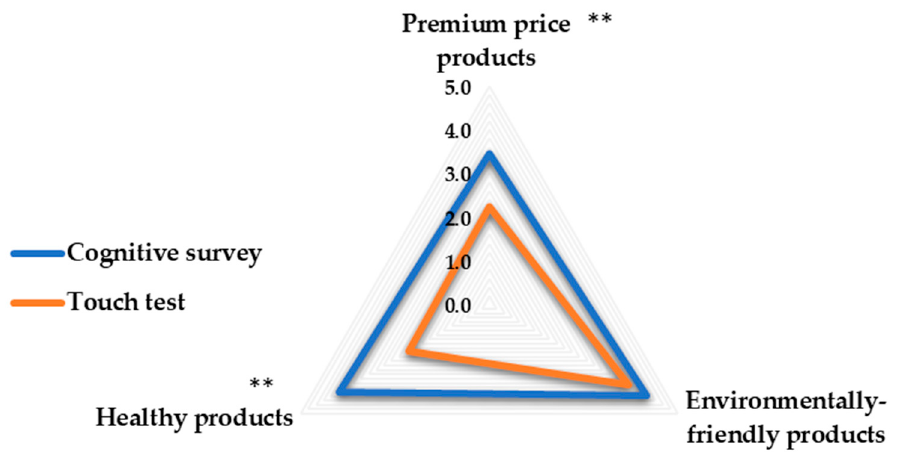
Figure 5. Spider diagram showing the differences in participants’ perceived aspect of organic product concept between the cognitive survey and the touch test. The rating was done on a 5-point scale: 1 = it does not represent the concept of the organic product at all, 5 = it highly represents the concept of the organic product. (*) Significant difference in the responses between the cognitive survey and touch test, ** p < 0.01.